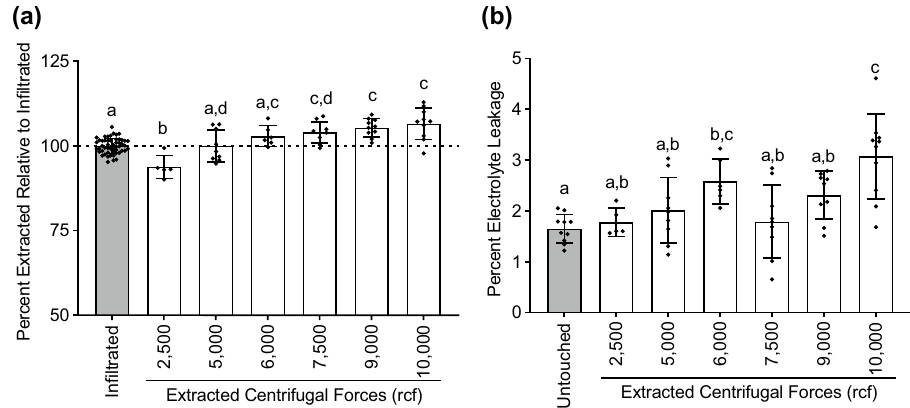
Figure 2. Evaluation of centrifugal force on Arabidopsis leaf apoplast extraction. ( a , b ) 5 week-old Arabidopsis leaves were vacuum-infiltrated with Milli-Q water and spun at different centrifugal forces for 10 min at 4 °C. ( a ) The percent of apoplast fluid extracted by centrifugation at the indicated rcfs, relative to the infiltrated amount, was calculated. ( b ) Percent electrolyte leakage was measured after centrifugation at the indicated rcfs. For each experiment, n = 2 or 3 samples/centrifugation speed, with each n consisting of 9 different leaves collected from 3 different plants. The experiment was performed 3 times and combined data (n = 6 to 9) is shown. Error bars are standard deviations and different letters denote statistically significant difference based on ordinary one-way ANOVA with Tukey’s multiple comparisons test ( p <